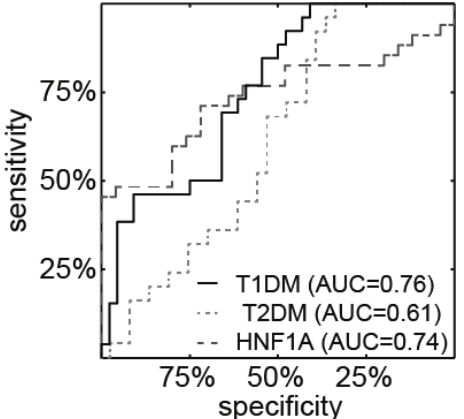
Figure 2. ROC analysis of miR-224. Levels of miR-224 in urine differentiated the normal control group from the T1DM, HNF1A-MODY mutation carrier and T2DM groups, respectively.